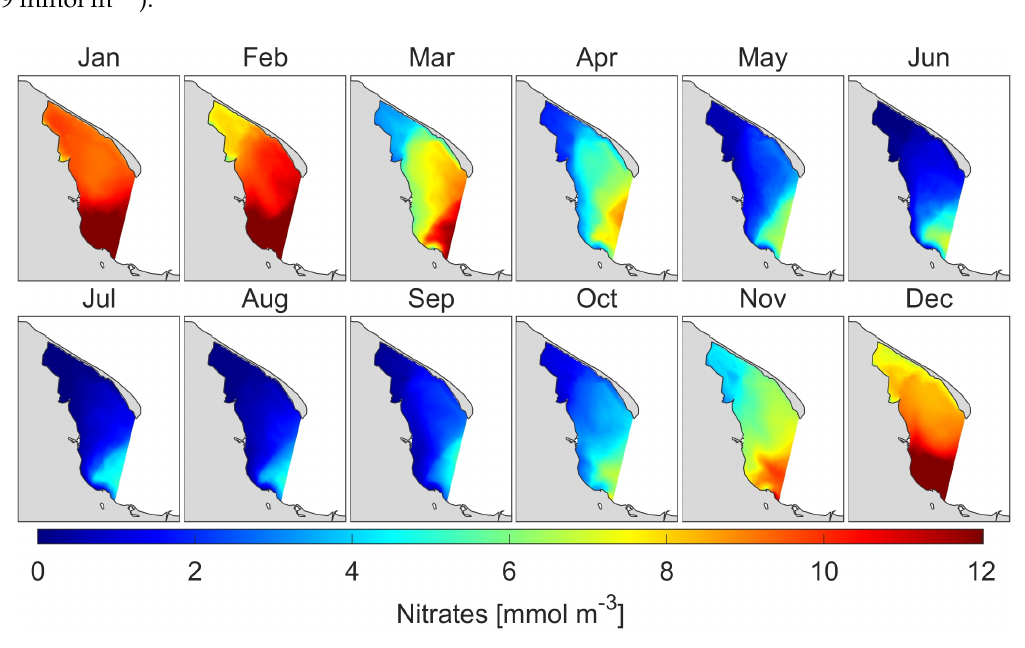
Figure 9. Monthly means of ammonia concentration at sea